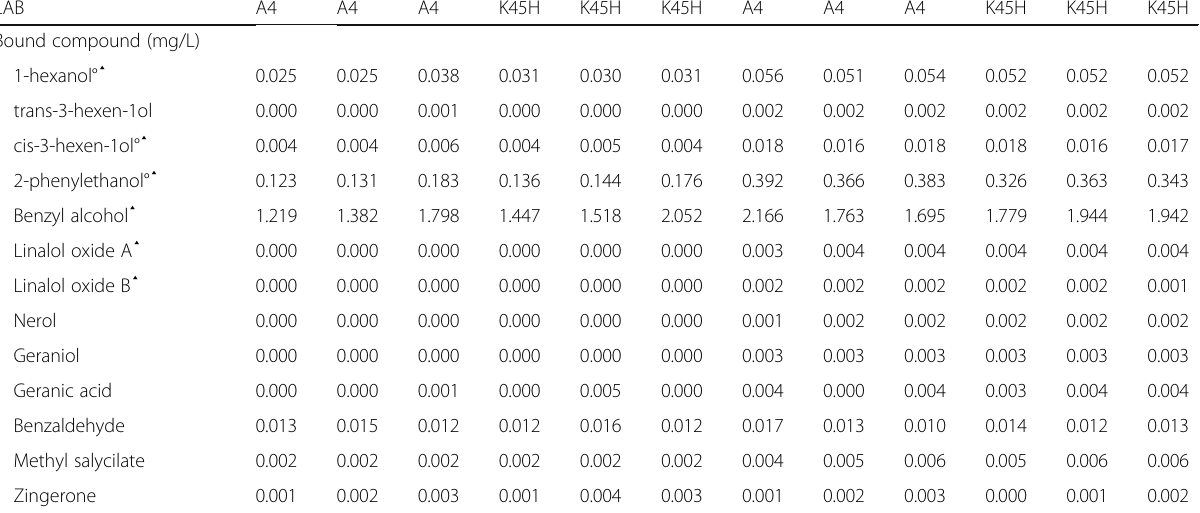
Table 3 Profile of free and bounded volatile compounds, determined by GC-MS, of wines obtained by simultaneous fermentation of S. cerevisiae and L. plantarum or O. oeni at different temperature profiles. T1 test: 16/22 °C in 3 days, B. T2 test: 18/24 °C in 3 days, and C. T3 test: 22/32 °C in 5 days. °Differences are statistically significant both in terms of bacteria strain and temperature profile effect (two-way ANOVA test, p = 0.05). ▴ Differences are statistically significant in terms of temperature effect (two-way ANOVA test, p = 0.05). *Differences are statistically significant in terms of strain effect (two-way ANOVA test, p = 0.05) (Continued)